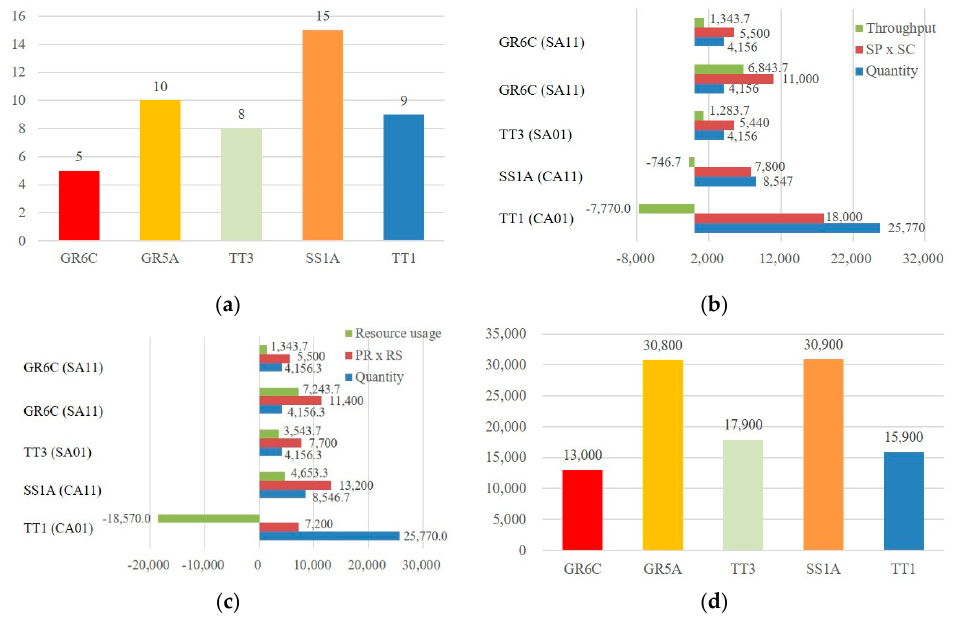
Figure 13. Productivity analysis of the ship production process through four key elements: ( a ) make-span, ( b ) throughput, ( c ) resource usage, and ( d ) resource cost. SP: space. SC: